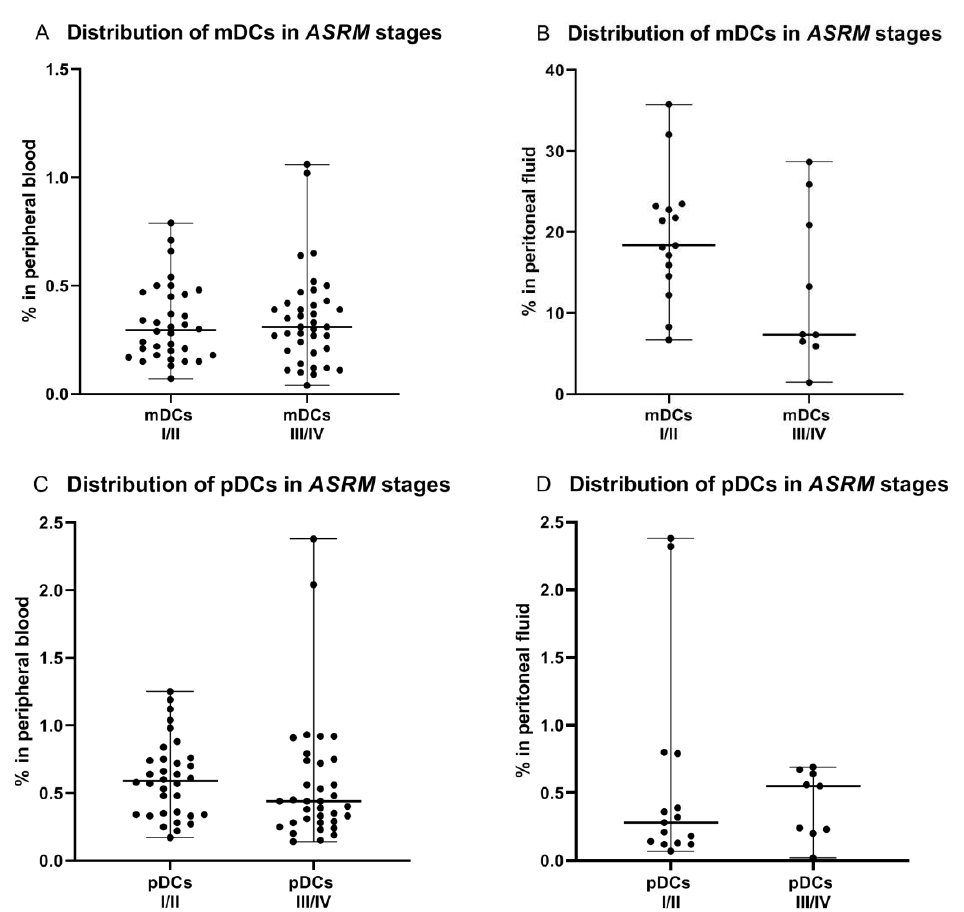
Figure 2. Percentage of mDCs and pDCs in peripheral blood and peritoneal fluid in early (I/II) and late (III/IV) ASRM stages of endometriosis ( A – D